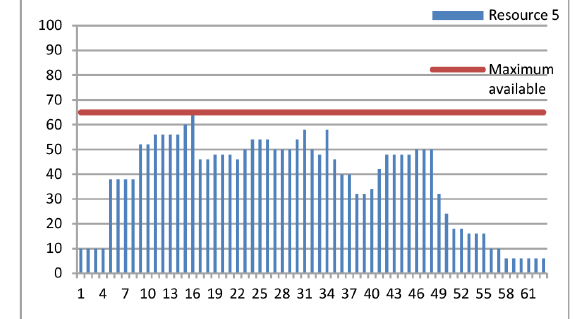
Figure 54. Daily usage of resource 5 throughout the calendar of the project (before using the method)-Experiment 3